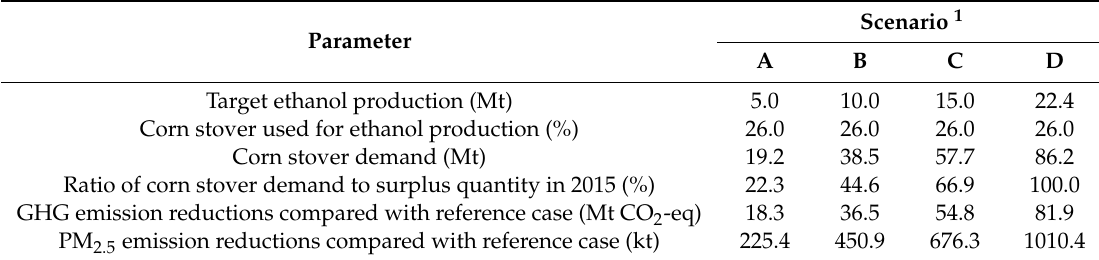
Table 6. Potential GHG and PM 2.5 emission reductions in corn stover based ethanol production under four scenarios in